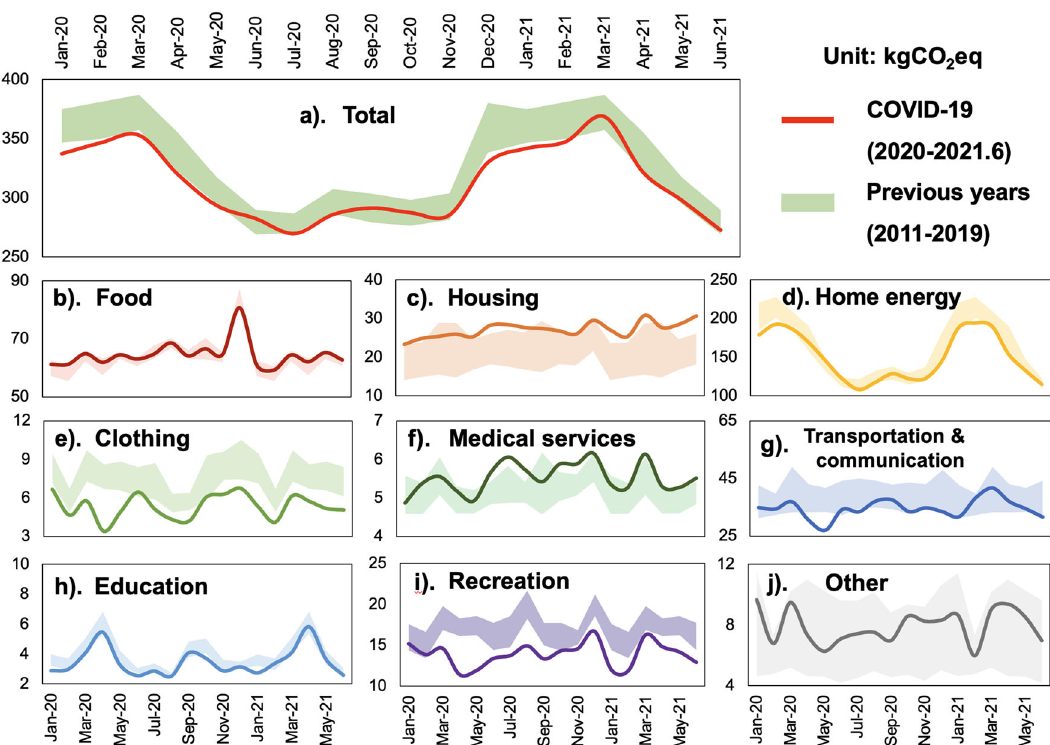
Fig. 4 City-level carbon footprints based on household demand (in kgCO 2 eq/cap/month) during the COVID-19 pandemic. The household carbon footprints in the following demand categories: a Total, b Food, c Housing, d Home energy, e Clothing, f Medical service, g Transportation and communication, h Education, i Recreation, and j Others,